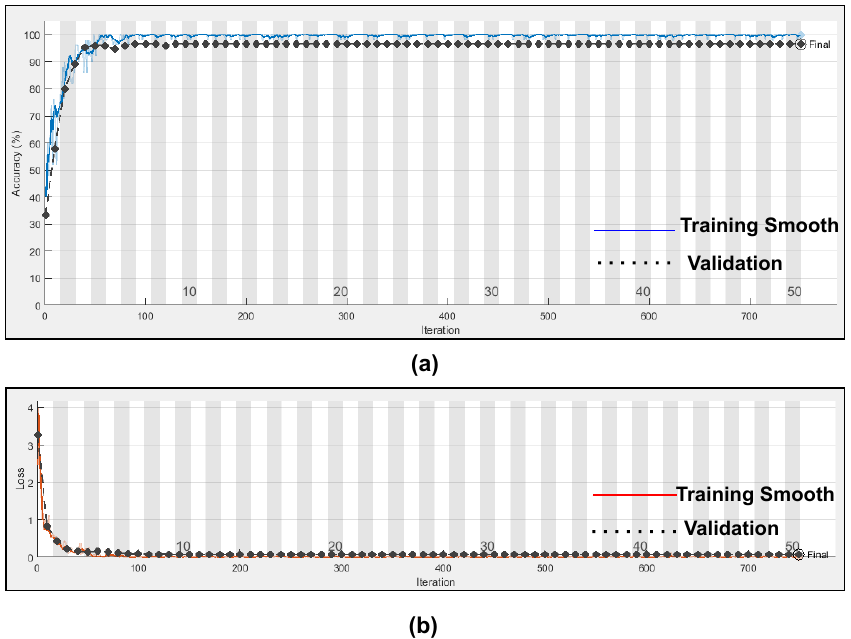
Figure 14. ( a ) Training progress and validation accuracy of proposed model using dropout regular- ization ( b ) Training progress and validation loss of proposed model using dropout regularization.